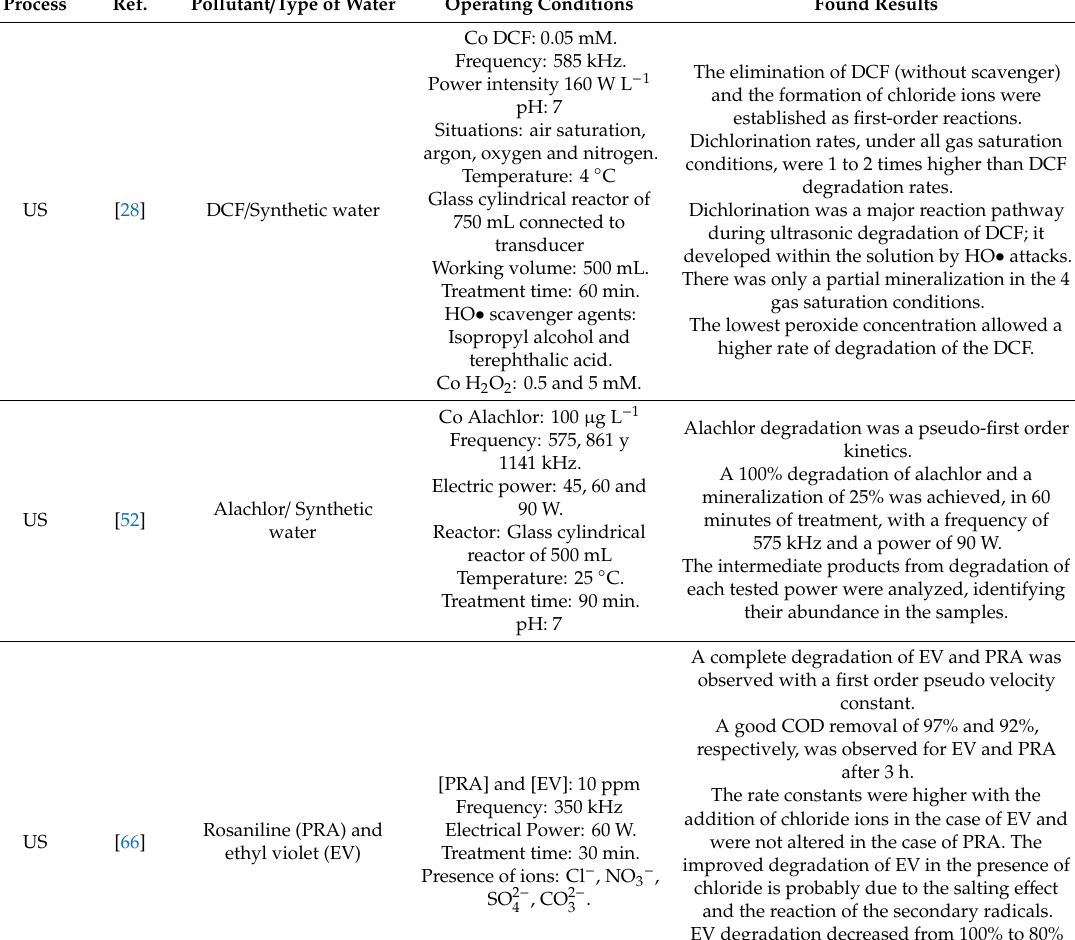
Table 2. Summary of works related to the removal of emerging pollutants through the ultrasound process and its combination with other physical-chemical and advanced oxidation